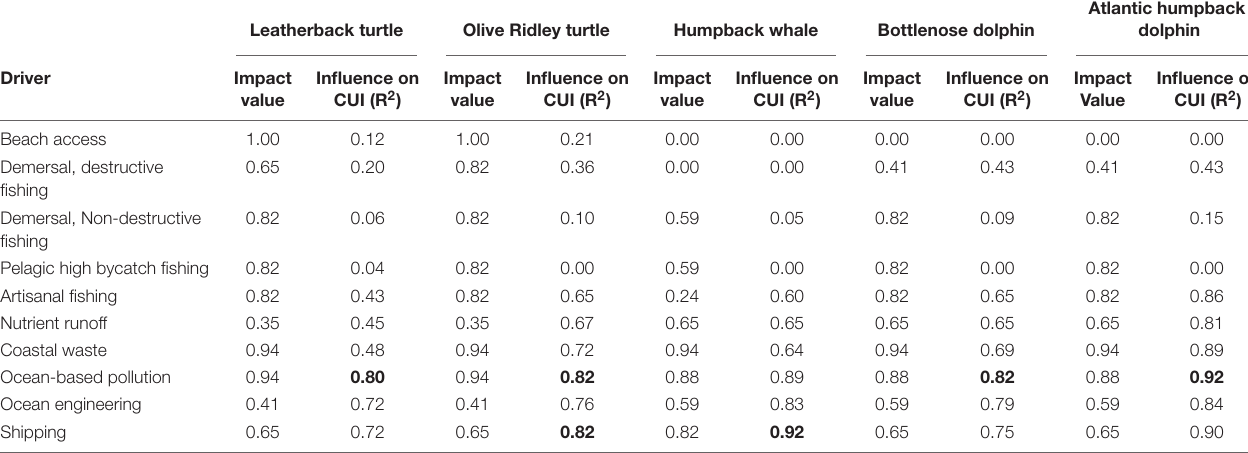
TABLE 4 | Influence of individual CUI layers on overall CUI distributions for individual species (R 2